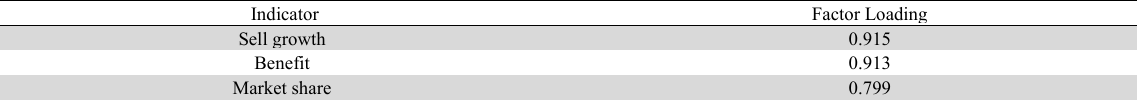
The Results of Factor Loading Marketing Performance Variable Test